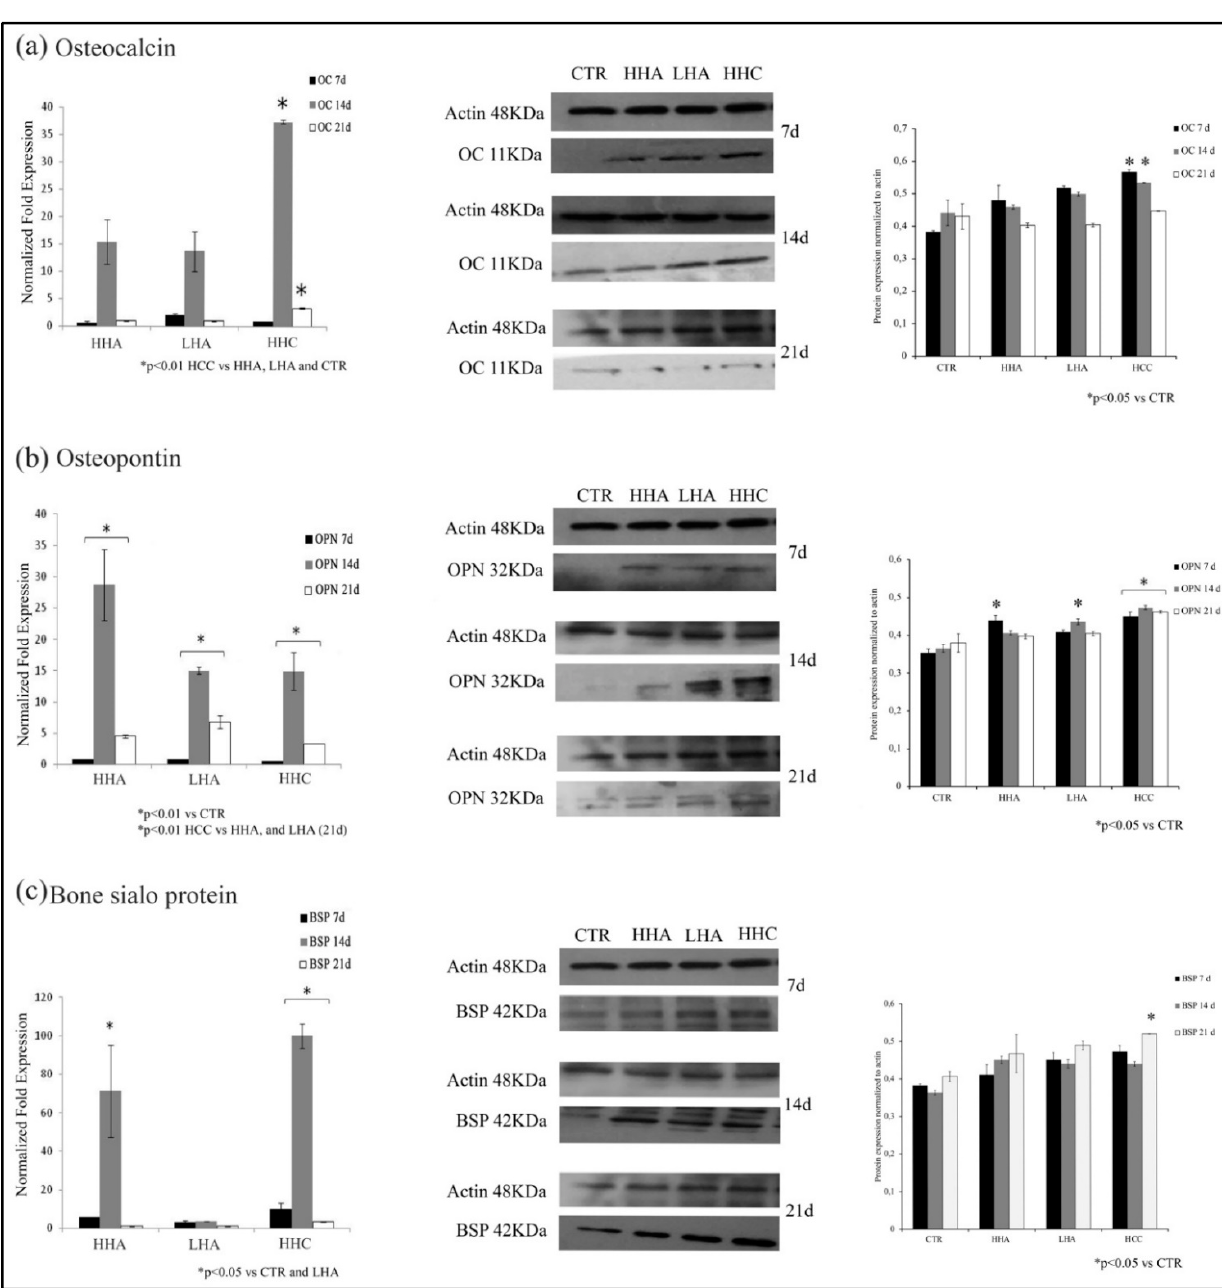
Figure 1. Analysis of OC , OPN and BSP gene expression at 7, 14 and 21 days by qRT-PCR and western blotting in standard medium. ( a ) OC gene expression was upregulated with a paramount activity of HCC at 7 and 14 days of treatment both at gene and protein level; ( b ) OPN gene and protein expression increased after HA treatment in 14 days; ( c ) BSP gene expression increased strongly at 14 days after HHA and HCC treatment, while protein expression is slightly higher in all HA treatments. The results are expressed as the mean ±SD of three independent experiments. * p < 0.01 versus CTR and other hyaluronans.